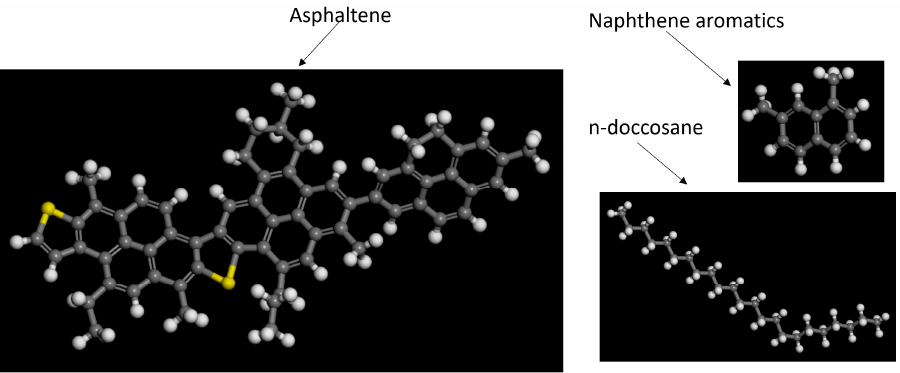
Figure 8. Typical asphaltene/napthene/saturates molecular structures.